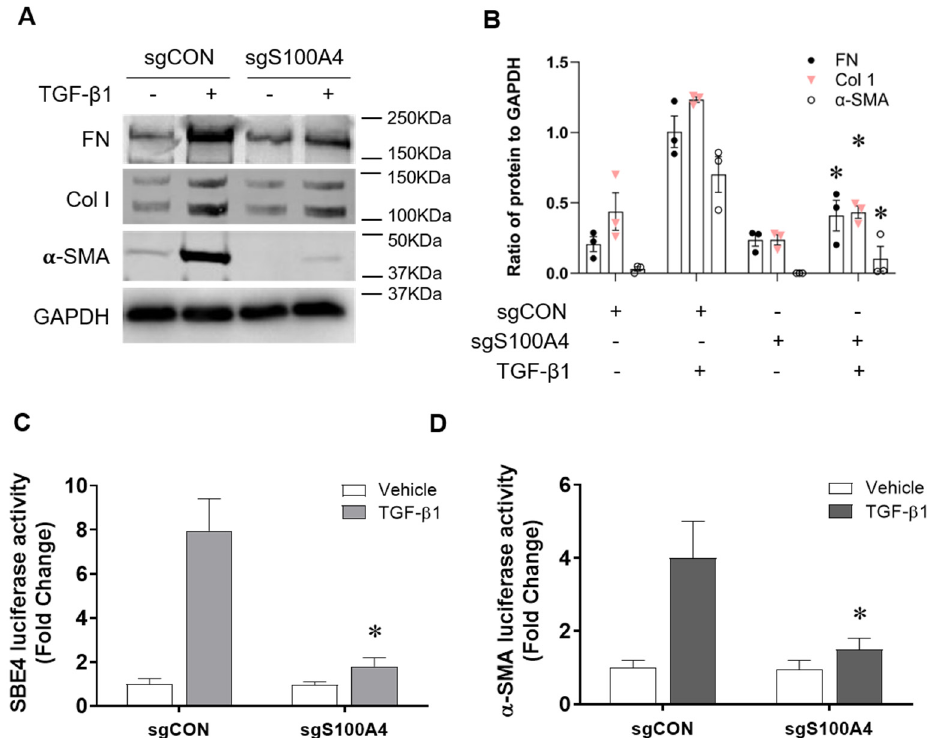
Figure 6. Knockdown of S100A4 inhibits fibroblast activation and TGF- β 1 induced transcriptional activity. ( A ) Representative Western blots show knockdown of S100A4 reduced protein levels of fibronectin, collagen 1 and α -SMA in NRK-49F cells treated with TGF- β 1 (2 ng/mL, 24 h). ( B ) Quan- titative analysis of levels of collagen 1, α -SMA and fibronectin in NRK-49F cells. ( C ) Luciferase assay shows knockdown of S100A4 attenuates TGF β -induced Smad3 promoter activity in NRK-49F cells. ( D ) Luciferase assay shows knockdown of S100A4 attenuates TGF- β 1-induced α -SMA promoter activity in NRK-49F cells. Data are expressed as Mean ± SEM of three independent